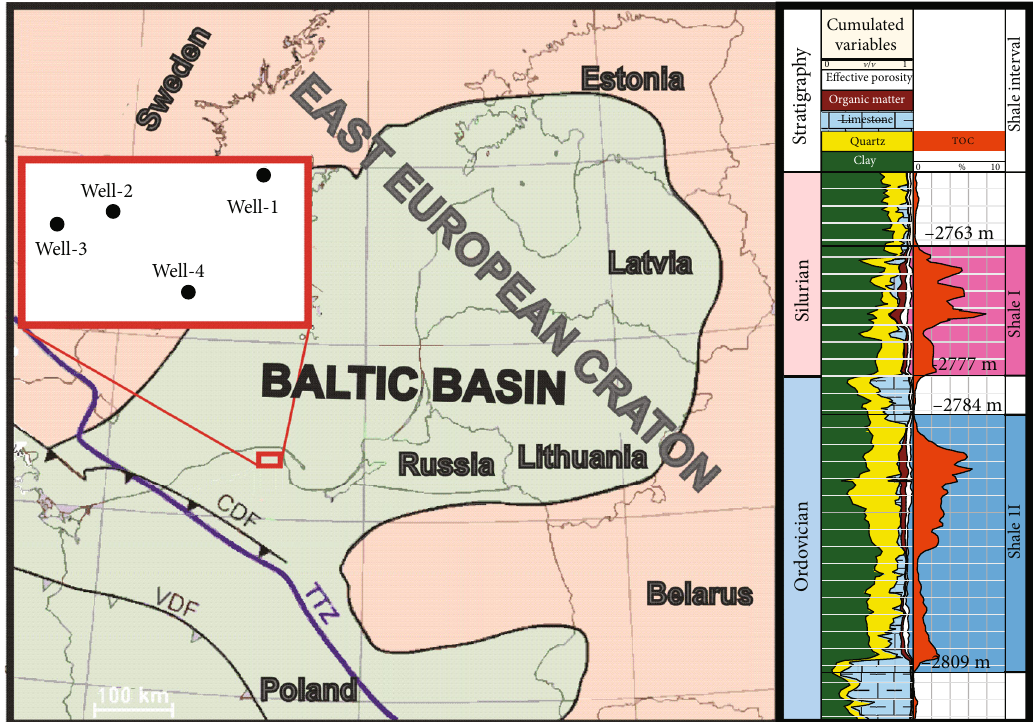
Figure 1: Location of the study area within the Polish onshore part of Baltic Basin (left); geological pro fi le of the Silurian and Ordovician shale formations